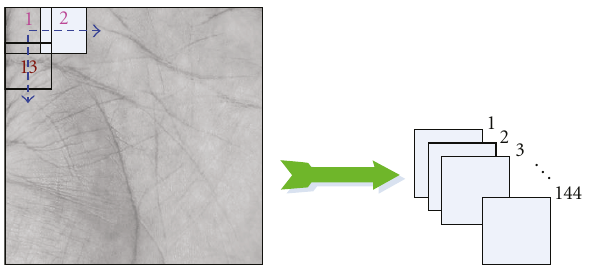
Figure 4: Localization of 144 overlapping palmprint image subblocks for feature